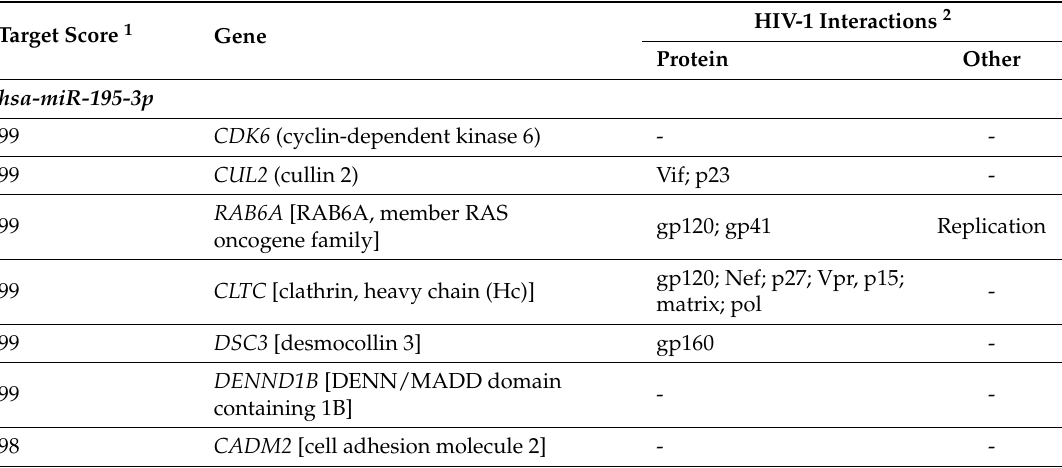
Table 3. List of miRNA with their predictive target genes and interaction with HIV-1. Target Score